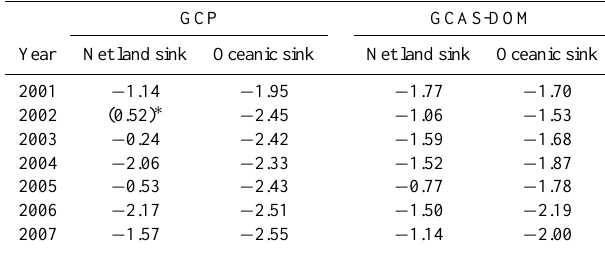
Table 2. Comparison of the optimized carbon sinks in this study with the “Global Carbon Budget 2013 v2.3” (in PgCyr − 1